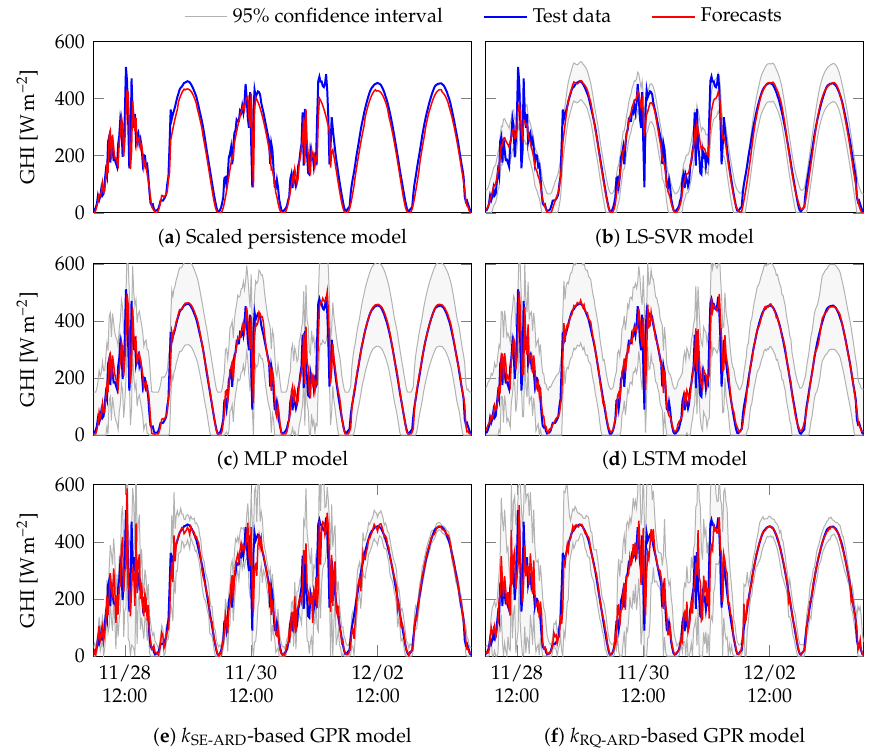
Figure 8. Examples of 10min forecasts of GHI given by the models included in the comparative study.